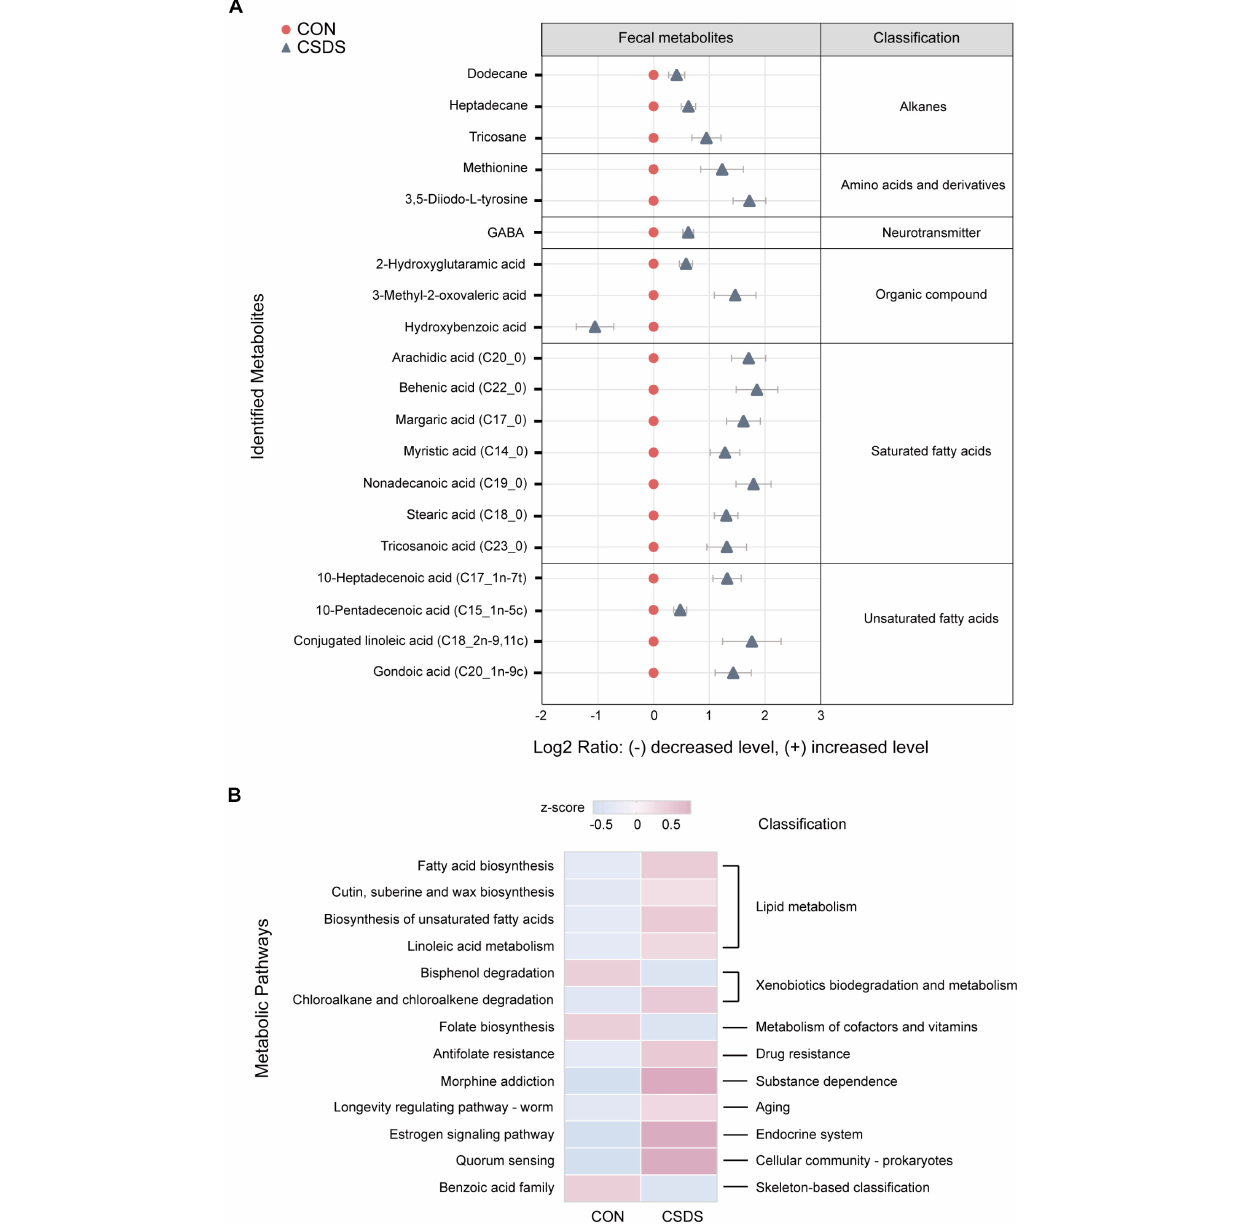
FIGURE 3 | Identification and pathway analysis of differential fecal metabolites between the control and CSDS mice. (A) 20 fecal metabolites were identified to be significantly changed in the CSDS mice. Compared to the control mice, only one metabolite (hydroxybenzoic acid) was significantly decreased, whereas the other 19 metabolites were increased in the CSDS mice. (B) Pathway analysis for fecal metabolites based on KEGG database revealed that 13 pathways were disturbed in the CSDS mice, of which most (4/13) were involved in lipid metabolism. CON, mice in the control group; CSDS, mice in the CSDS